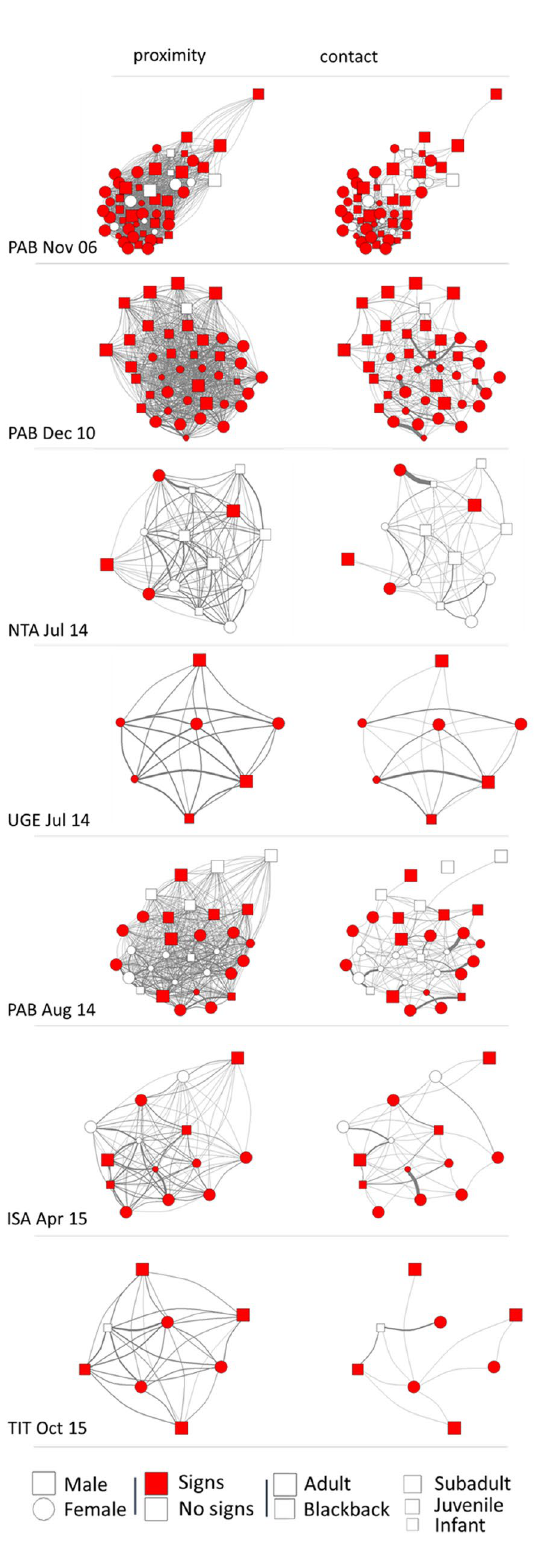
Figure 2. Weighted undirected social networks based on proximity within 5 m and physical contact for each of the 7 outbreaks between 2004 and 2015, based on focal scans collected 3 months either side of the start of the outbreak. Red indicates individuals that were symptomatic at any point during the outbreak. Networks were plotted in igraph using the Fruchterman–Reingold layout algorithm based on the proximity network (to remain consistent between the two network types). The edge width indicates the strength of the dyadic relationship based on the simple ratio index. For visualisations of the temporal spread of signs of respiratory infection in each network, see Supplementary Videos